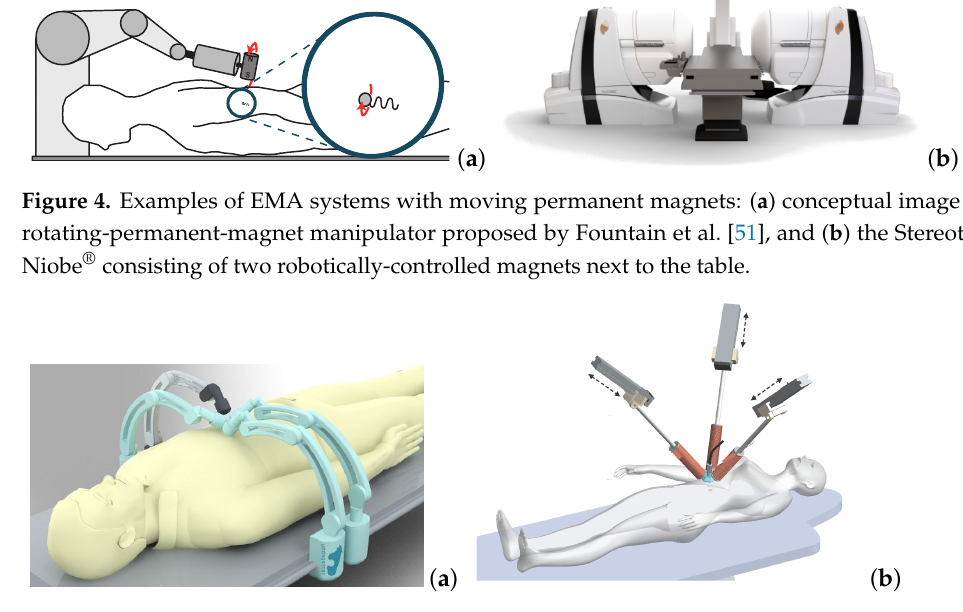
Figure 5. Examples of EMA systems with moving electromagnets: ( a ) the robot-assisted magnetic manipulation proposed by Véron et al. [88], and ( b ) the DeltaMag system consisting of three parallel mobile coils